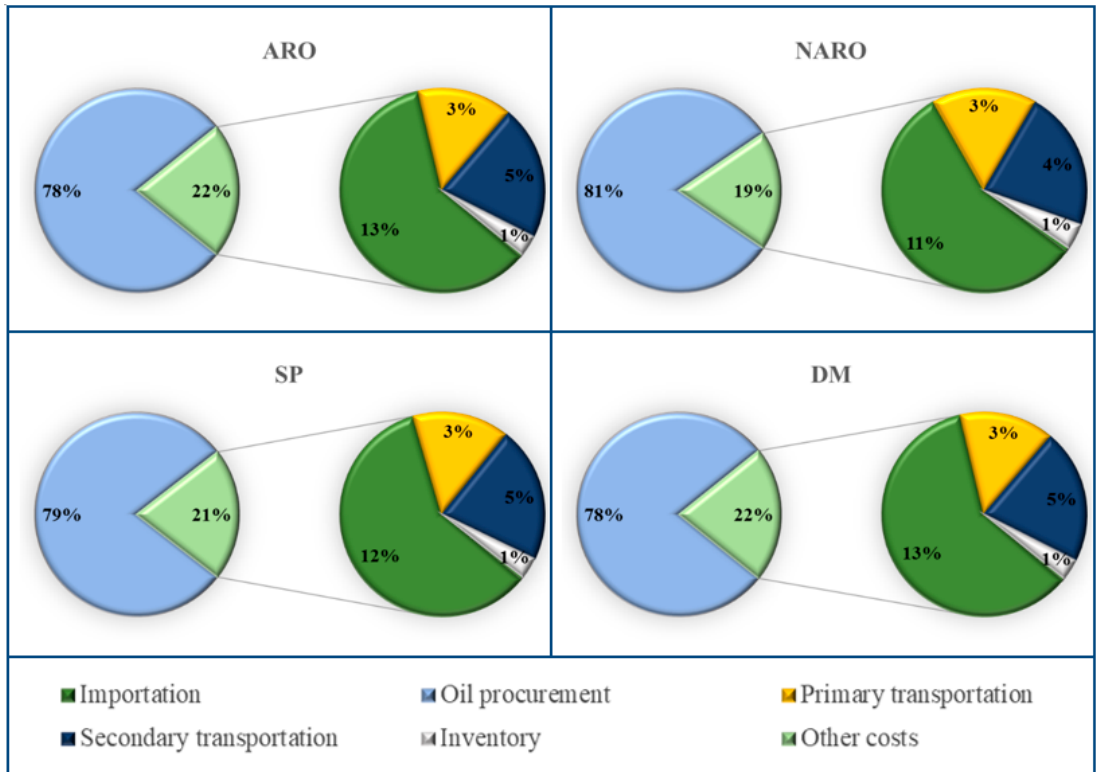
Figure 4. Cost breakdown for the optimization models.